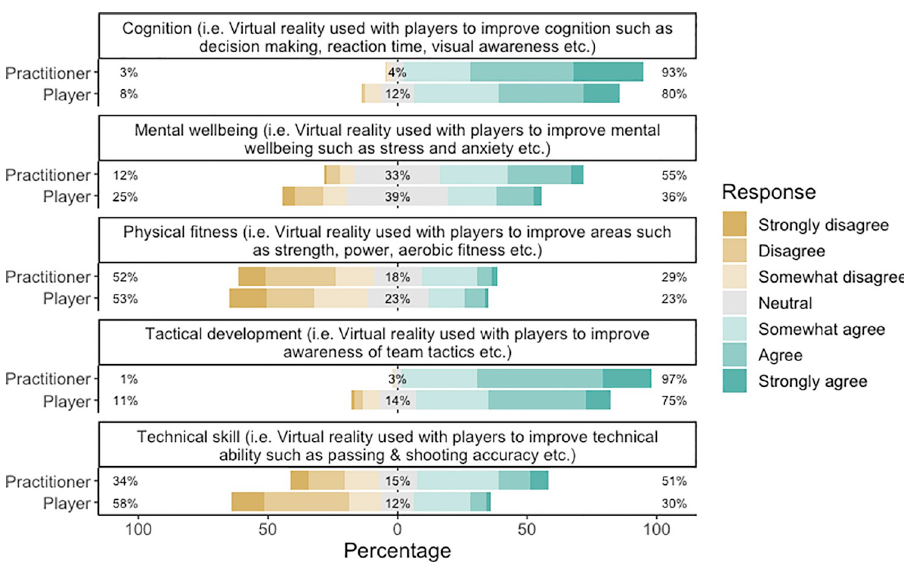
Fig 1. Responses by practitioners and players to statements regarding what VR should be used for. Percentages indicate overall disagreement, neutral and overall agreement, from left to right respectively.